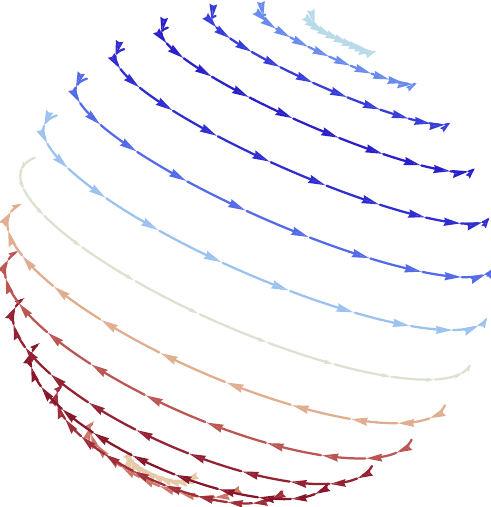
Fig. 1 Flux of the electric current (14) linearly induced by static elec- tric charge placed into parallel electric and magnetic background fields (outside the charge). The current revolves about the axis drawn along the common direction of the background fields. The brighter the arrow- head lines, the larger the current